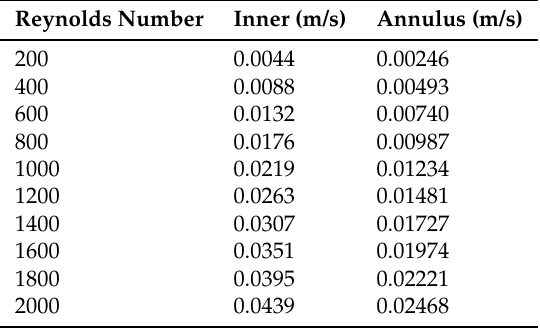
Table 5. Inlet velocity boundary condition for hot and cold